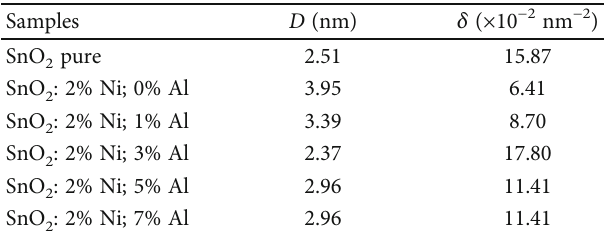
Figure 4: T (110) and T (101) plotted against the aluminum C C concentration. Table 2: Average crystallite size and dislocation density of Al-Ni- codoped SnO thin fi lms prepared at di ff erent concentrations of 2 aluminum.